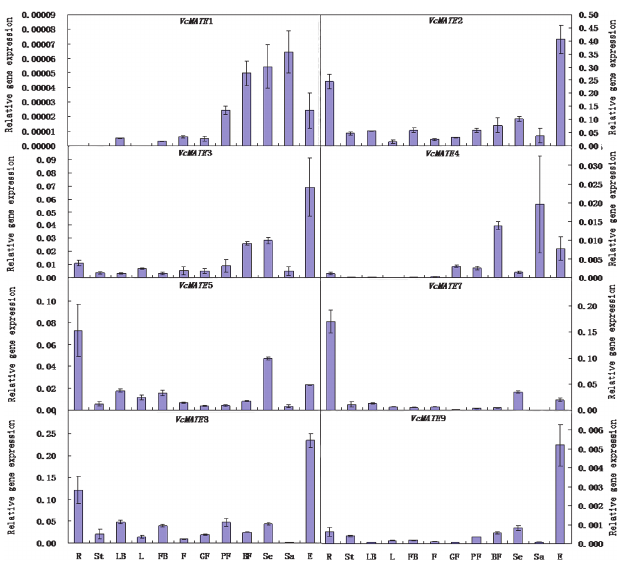
Fig 6. Relative gene expression levels of MATE-encoding genes in various blueberry organs and different developmental stages of fruit. Total RNA was isolated from roots (R), stem(S), flora buds (FB), flowers (F), leaf buds (LB), young leaves (YL), green fruit (GF), pink fruit (PF), blue fruit (BF), exocarp (E), sarcocarp (Sa), and seed (Se). Gene expression was normalized with Vm GAPDH. All data represent the mean of three replicates with error bars indicating